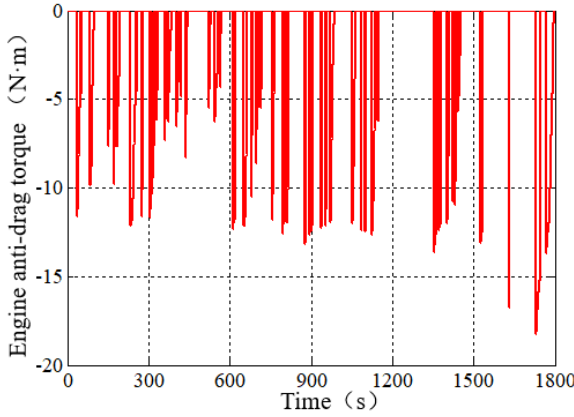
Figure 18. Engine anti-drag torque in the WLTC condition.